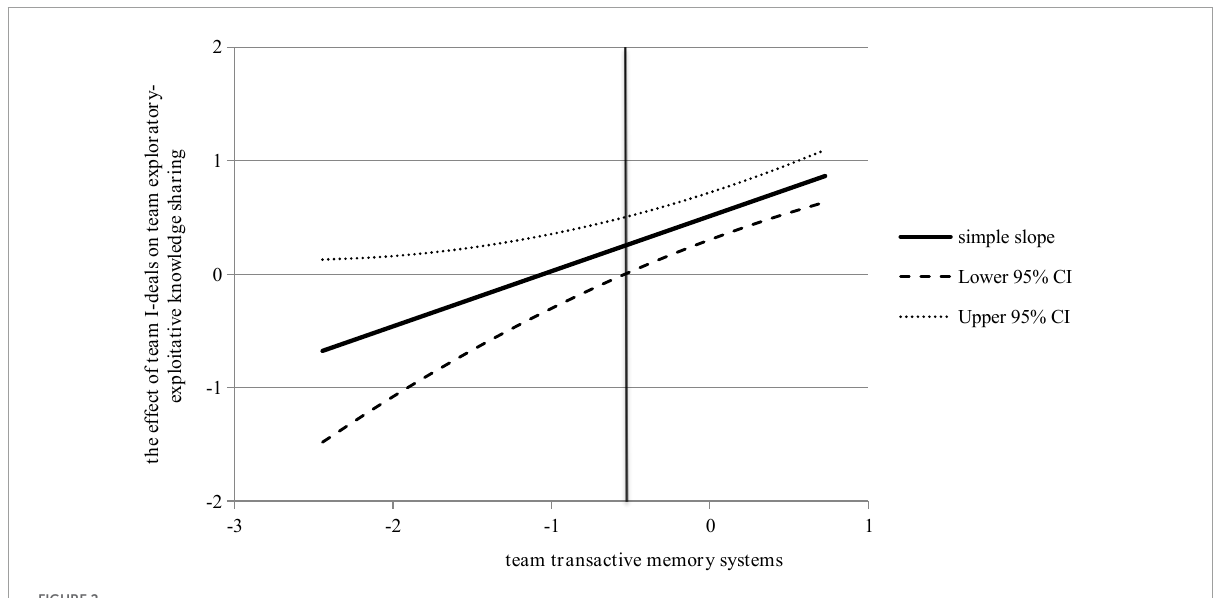
FIGURE2 The moderating role of TTMS (J-N). This figure shows the value range of TCF (after decentralization), and what value it takes to show the moderating effect.